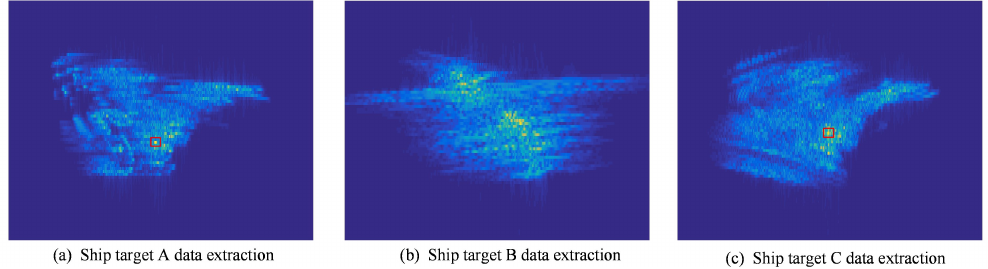
Figure 12. Ship target extraction